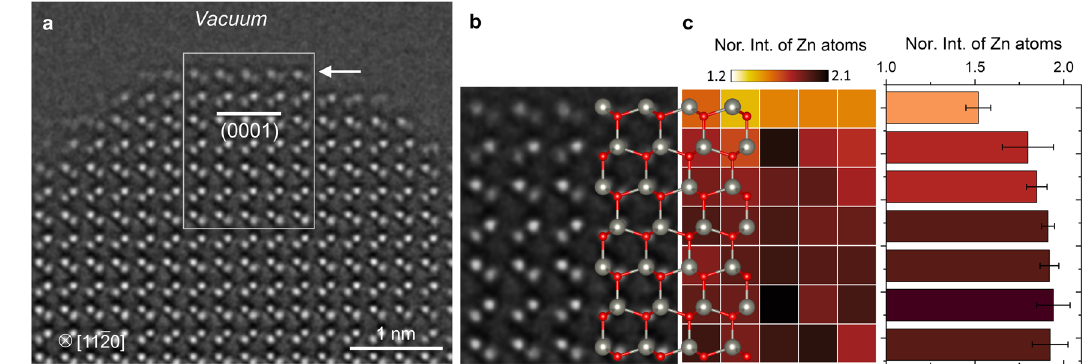
Fig.1|HRTEMimageofapristineZnO(0001)surfaceandquantitativeanalysis oftheintensityofZnatomiccolumns.a HRTEMimageofZnOcrystalrecordedat a NCSI condition. The Zn-terminated (0001) surface in edge-on orientation is indicated by white arrow. b Magni fi ed viewof the region outlined by white lines in a .TheregionwasselectedforthequantitativeanalysisoftheintensityofZnatomic